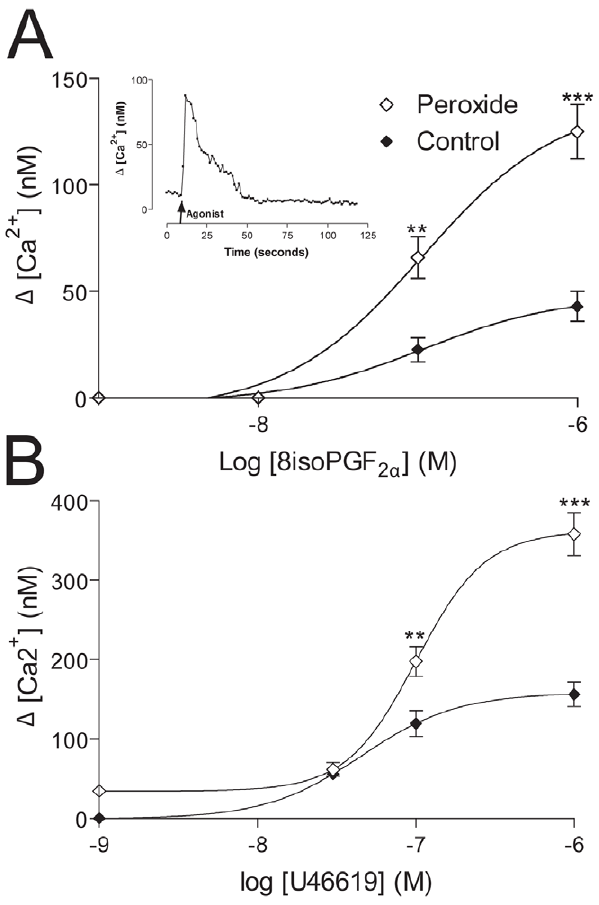
Figure 8. Hydrogen peroxide exposure relieves receptor desensitization and leads to potentiation of calcium mobiliza- tion following repeat challenge by U46619. HEK293 cells stably expressing HA-TP b were loaded with FuraRed (20 m M) for 30 minutes at 37 u C in the presence of pluronic F127. Cultures were given an initial challenge of U46619 (1, 30 and 100 nM) and visualized under a Zeiss Axiovert 200 microscope. Cytosolic calcium concentration was calcu- lated as described in methods. Following the first challenge, cells were washed three times in recording buffer and incubated for a further 30 minutes at 37 u C. A second challenge of U46619 was carried out as previously. Panel A is representative single traces demonstrating the effect of receptor desensitization in the presence and absence of hydrogen peroxide. Following an initial challenge of U46619 the second dose of ligand (100 nM) was added at the point indicated in the figure. In the absence of hydrogen peroxide an additional calcium transient was not detected, but by contrast, a calcium transient was observed in H 2 O 2 -treated cells. Panel B shows concentration-response data for the repeated U46619 challenge in the presence of hydrogen peroxide (10 m M). These observations were found to be significant (P , 0.05) at 100 nM (*), the data representing the mean 6 SEM,